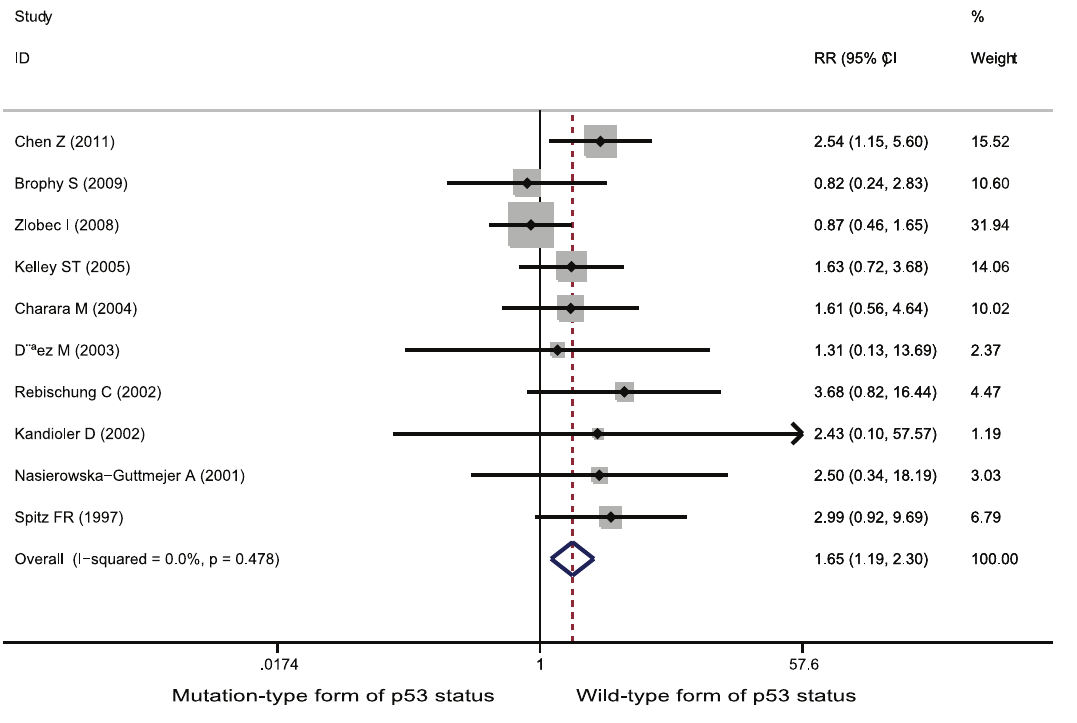
Figure 3. Forest plots of RR were assessed for association between p53 and complete response among rectal cancer patients treated with neoadjuvant radiation-based